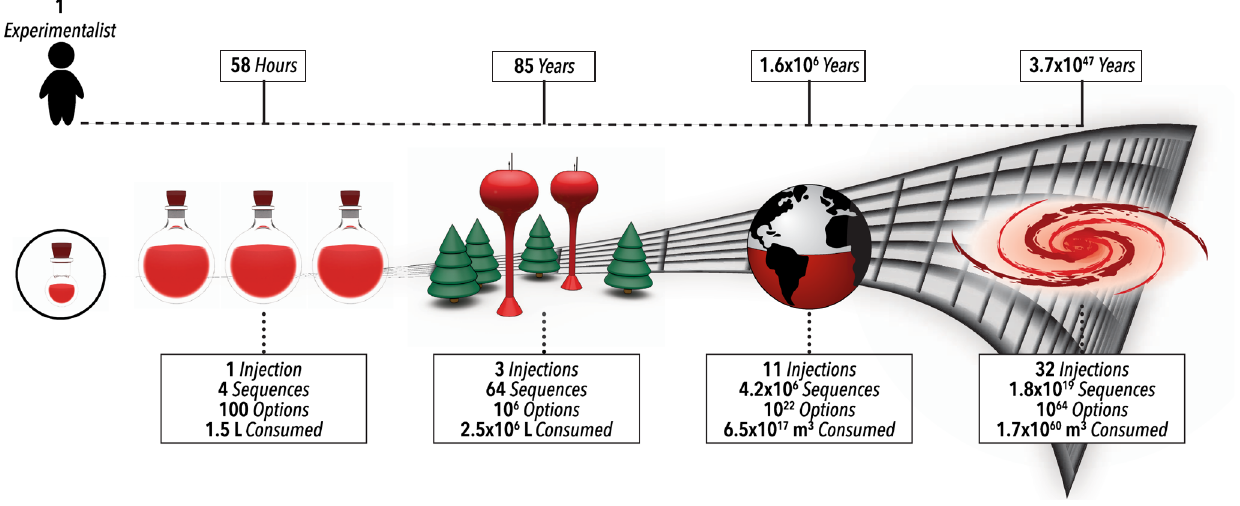
Fig. 1 | Curse of dimensionality in multi-step chemistry. Illustration of the exponentially increasing complexity and required resources for a batch multi-step synthesis consisting of four possible step choices, up to 32 sequential steps. Reaction option estimates are based on four possible reagents, fi ve possible